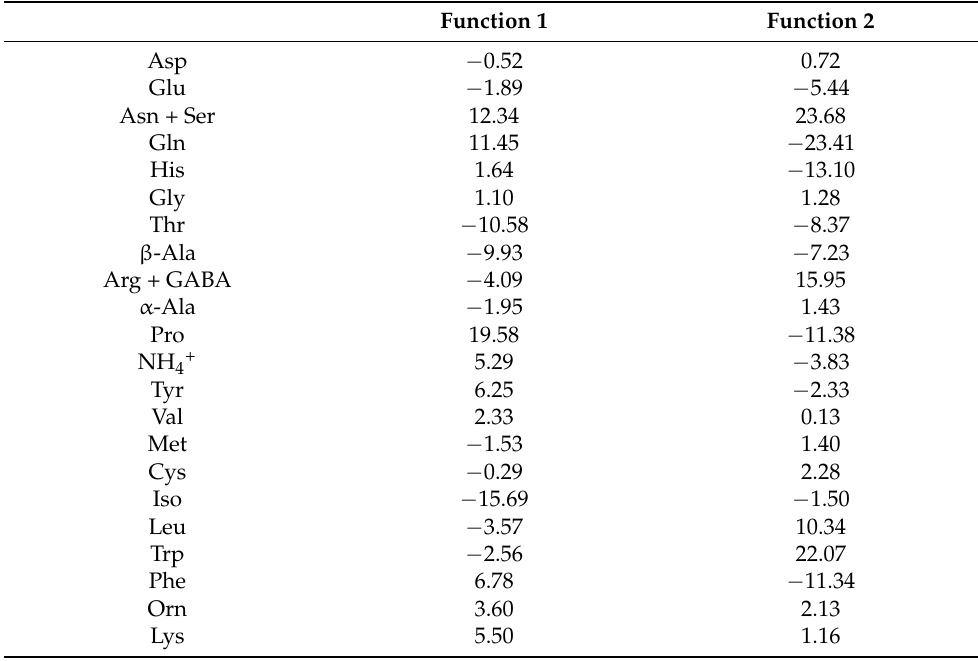
Table 5. Standardized coefficients of the discriminant